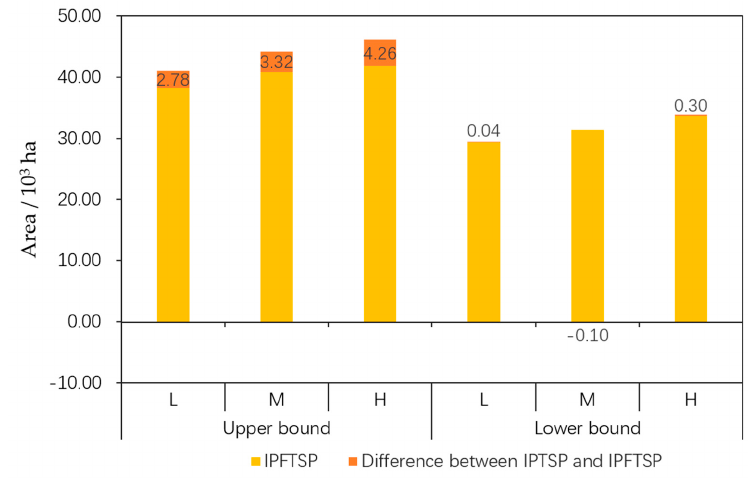
Figure 6. Comparison of the total recovered area of the ecological function regions between IPFTSP model and IPTSP model under different flood flow scenarios. L, M, and H denote low, middle, and high flood flow scenarios, respectively.